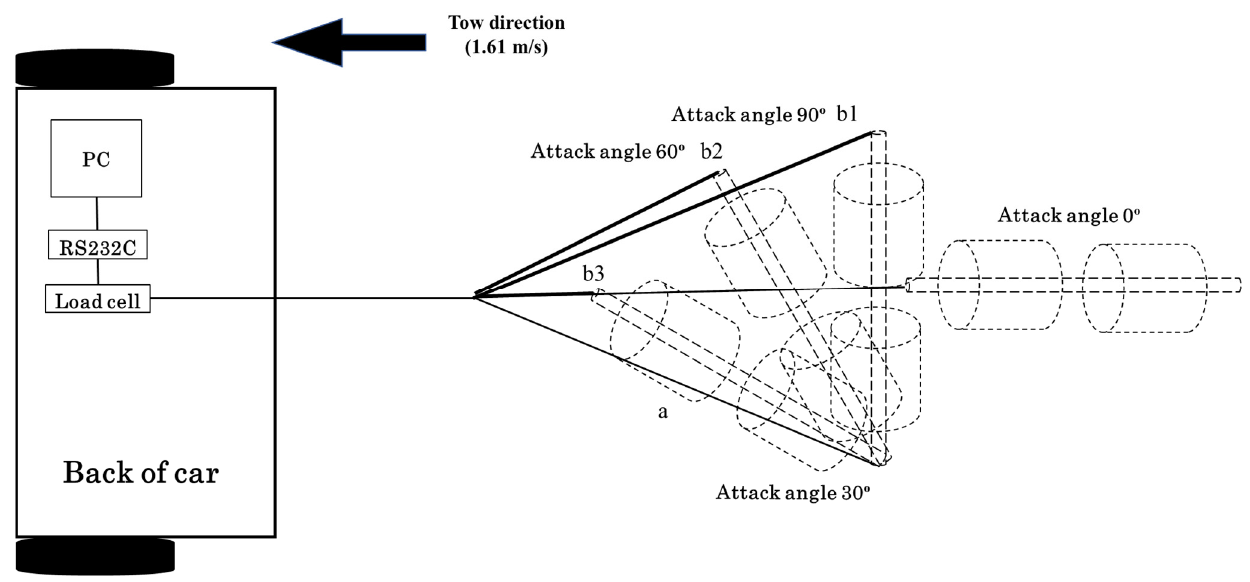
Figure 2. Diagram showing the different ground gear setups used in the towing experiment. Attack angle was controlled by changing the length of rope (b1 at 90 degrees, b2 at 60 degrees and b3 at 60 degrees) on one side against fixed the length of rope (a) on other side. When the attack angle was 0 degrees, the attack angle was controlled by using only a fixed length of rope (a) and not using changed rope (b).